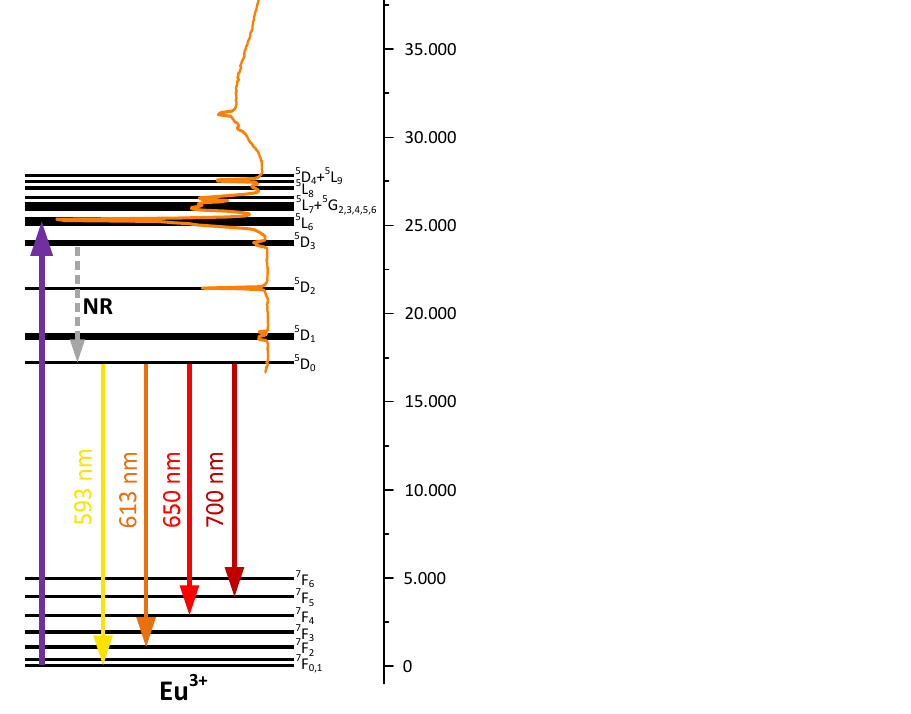
Figure 11. Scheme of the energy levels of Eu(III) together with most efficient excitation path, excitation spectrum, and emission transitions from 5 D 0 level (NR—non-radiative transitions).